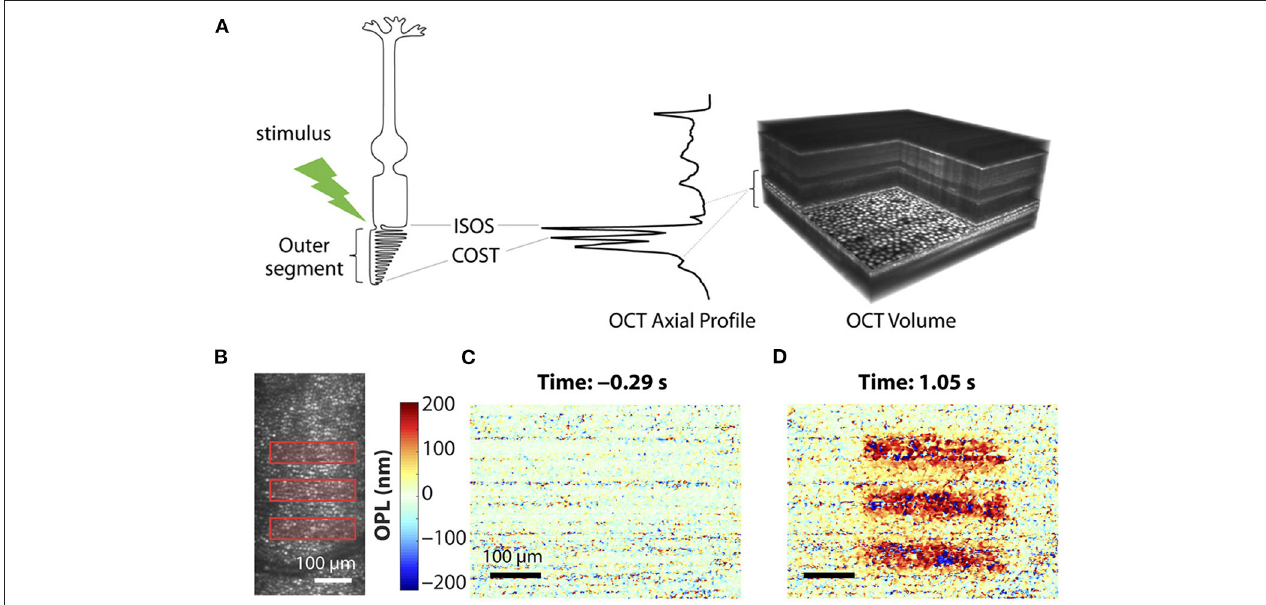
FIGURE 4 | Phase-resolved OCT imaging for optical path length (OPL) estimation. (A) Optoretinography experimental paradigm. A three-dimensional (3D) OCT volume with AO allows resolving the cone mosaic in an en face projection and the outer retinal layers in an axial profile corresponding to the ISOS and COST. Stimulus (528 ± 20nm, green)–driven changes in a cone photoreceptor are accessible by computing the time-varying phase difference between the proximal and distal OCT reflections encasing the outer segment. (B) Optoretinography reveals functional activity in cone outer segments. Illumination pattern (three bars) drawn to scale over the line-scan ophthalmoscopic image. (C,D) The spatial map of OPL changes between the ISOS and COST before (C) and after stimulus (D) , measured at 20-Hz volume rate. Reprinted with permission from Pandiyan et al. (